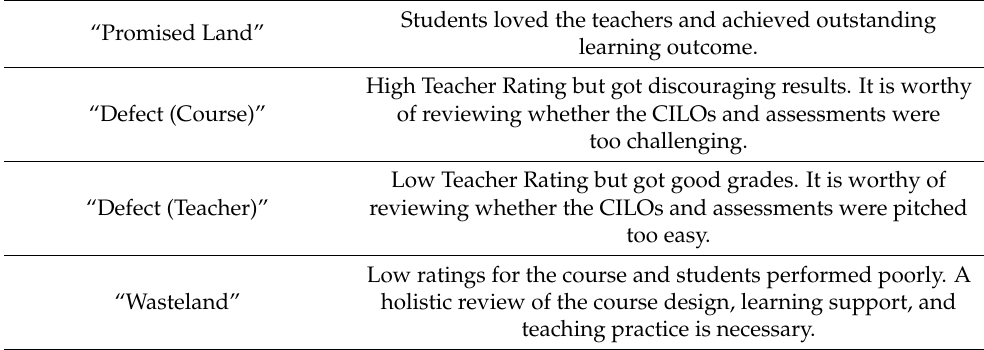
Table 7. The definition of Course Average Grade Point–Teacher Rating Matrix.